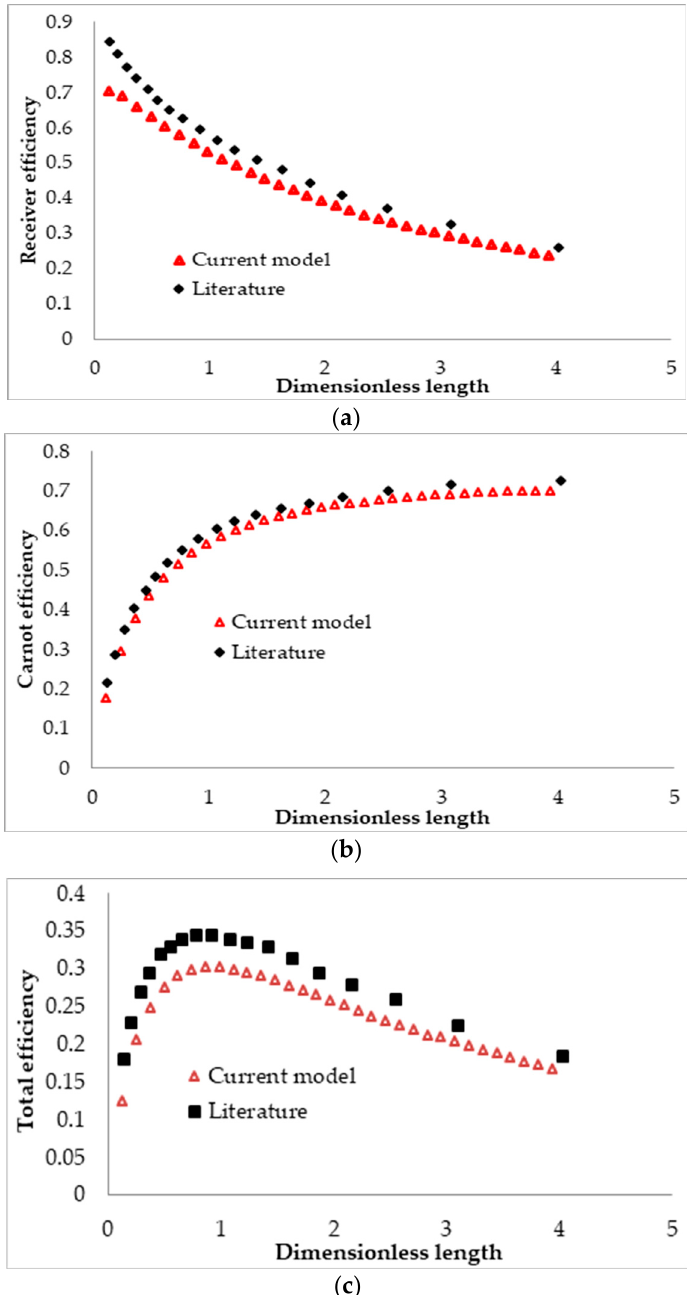
Figure 4. Comparison between the calculated efficiency using the current model and A. Veeraragavan’s model [51]: ( a ) receiver efficiency, ( b ) Carnot efficiency, and ( c ) total efficiency.